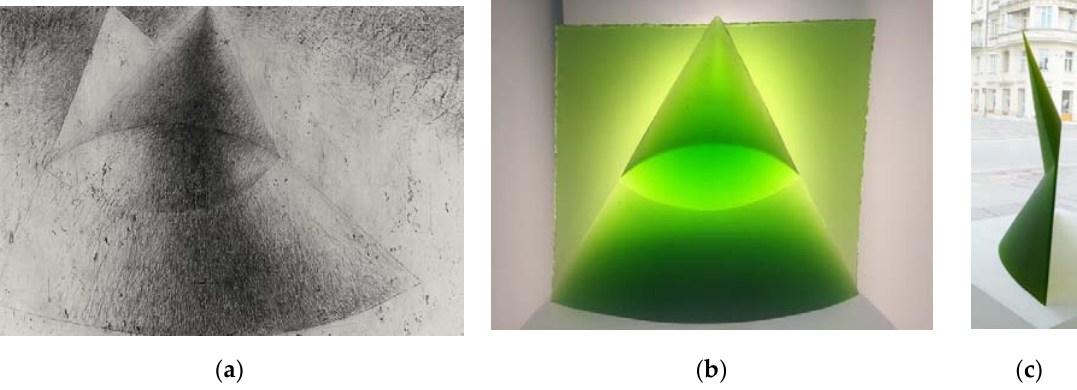
Figure 4. Prediction and reality. Photographs by the author. ( a ) Stanislav Libensky, design drawing for Green Eye of the Pyramid. ( b ) Stanislav Libensky and Jaroslava Brychtova, Green Eye of the Pyramid, 1993–2009, cast glass. ( c ) Stanislav Libensky and Jaroslava Brychtova, side view of Green Eye of the Pyramid, 1993–2009, cast glass.